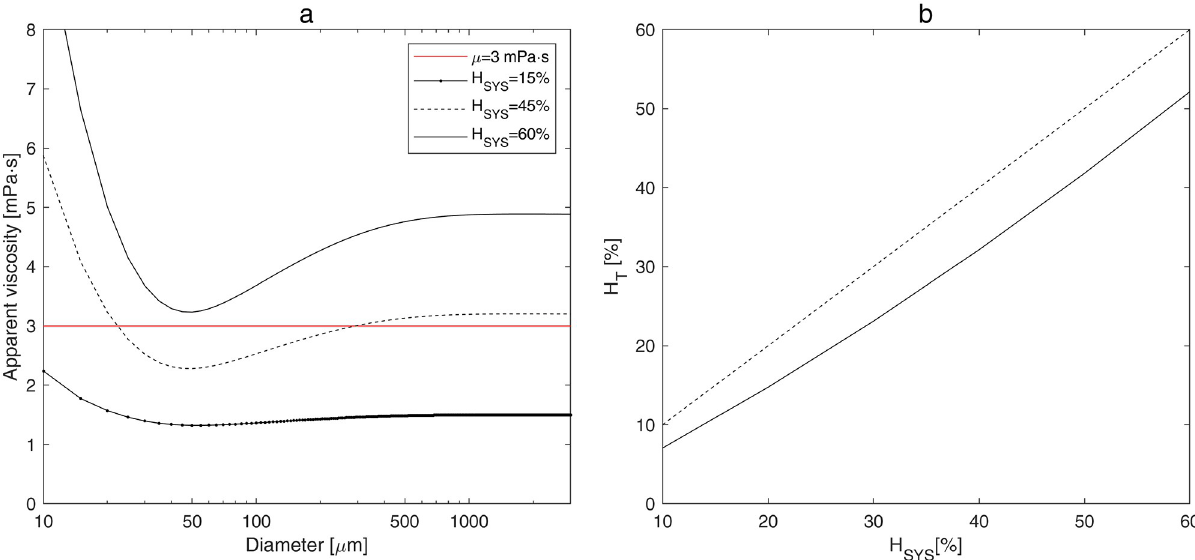
Fig 1. Calculated apparent blood viscosity and tube hematocrit. (a) Calculated apparent blood viscosity versus diameter of vessel for different values of systemic hematocrit. (b) Tube hematocrit versus systemic hematocrit (dashed line H T = H SYS is shown for comparison).